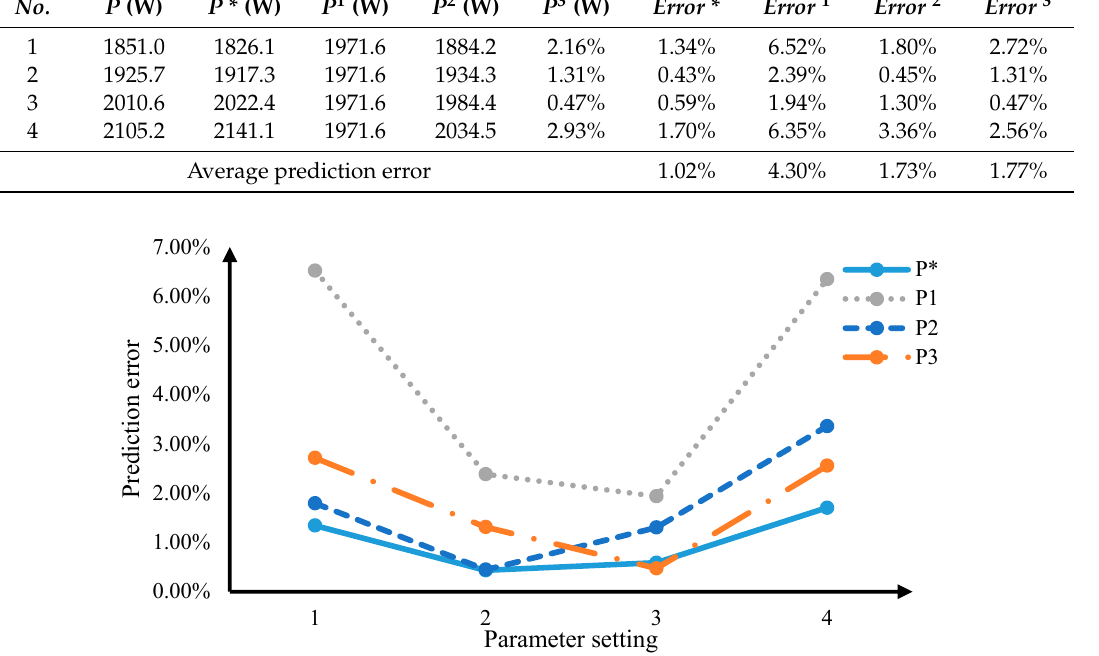
Figure 9. The prediction errors of the four models (Experiment-II).